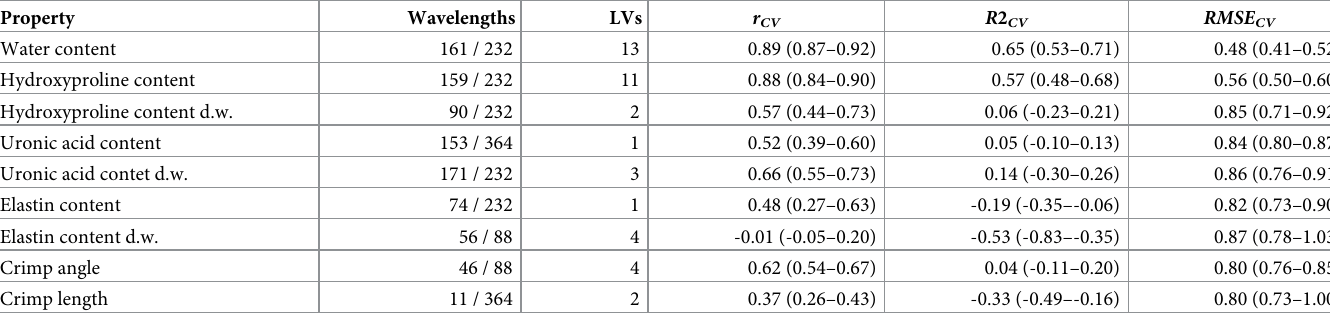
Table 2. Median cross-validated correlation ( r CV ), R 2 CV , and root mean squared error ( RMSE CV ) of different reference properties.